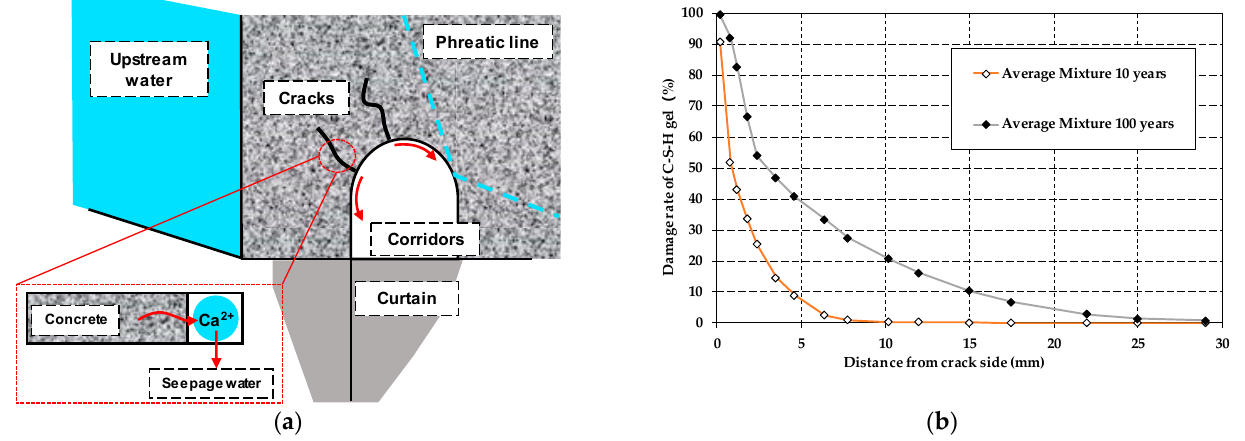
Figure 9. Long ‐ term performance analysis of dam concrete: ( a ) the principle of calcium precipitation in the corridor; ( b ) long ‐ term performance simulation of concrete dam.